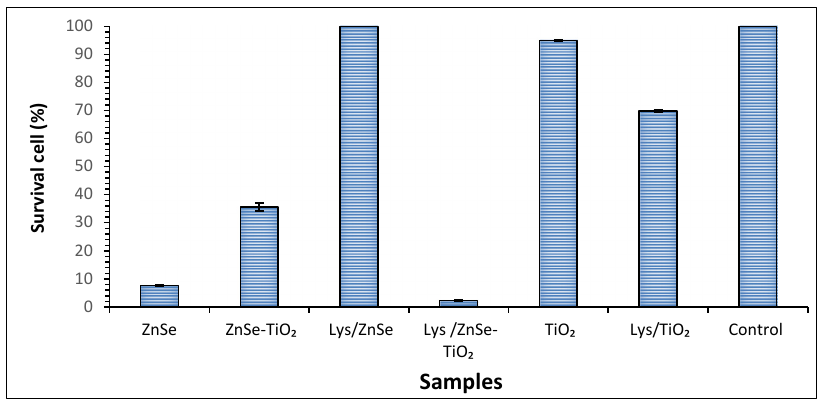
Figure 19. Survival cell percentage of S. aureus ATCC 25923 after four hours of exposure to synthesized materials. The data are presented as the mean of three independent measurements, with error bars representing the standard deviation of the mean.